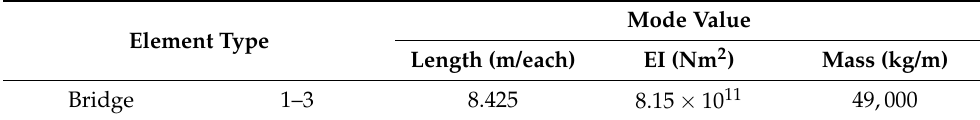
Figure 3. ( a ) First span of Hollandse Brug; ( b ) first and second mode shape. Table 1. Parameter of each element (deterministic